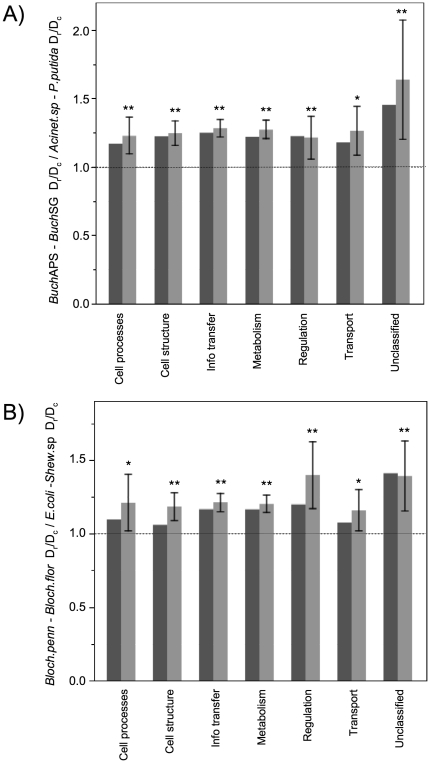
Empirical data: Elevated Dr/Dc in endosymbionts is consistent across functional categories.The ratio of Dr/Dc values for endosymbiont pairs divided by Dr/Dc for free-living bacterial pairs (or, the ‘elevation index’ described in the text) consistently exceeds one, indicating higher Dr/Dc in the endosymbionts. This pattern holds across diverse functional categories, including core cellular processes such as information transfer. Median (dark grey) and mean values (light grey, with bars showing 95% confidence intervals) are based on 256 shared orthologs shared among genomes. Asterisks indicate that the lower bound of the 95% (*) or 99% (**) confidence interval of the ‘elevation index’ exceeds one, which is marked with a hashed reference line. Functional categories are based on MultiFun assignments to E. coli orthologs [72], [73]. When E. coli genes were assigned to more than one broad category, that ortholog is represented more than once in the summary data presented. The numbers of orthologs analyzed for each functional category are as follows: Cell processes, 23; Cell structure, 73; Information transfer, 122; Metabolism, 112; Regulation, 19; Transport, 22; Unclassified, 14. Figure S1 shows the data points underlying the mean and median values presented here. Table S3 provides 99% confidence intervals and the results of sign and Wilcoxon tests, which also support significant elevation in endosymbiont Dr/Dc values across functional groups.